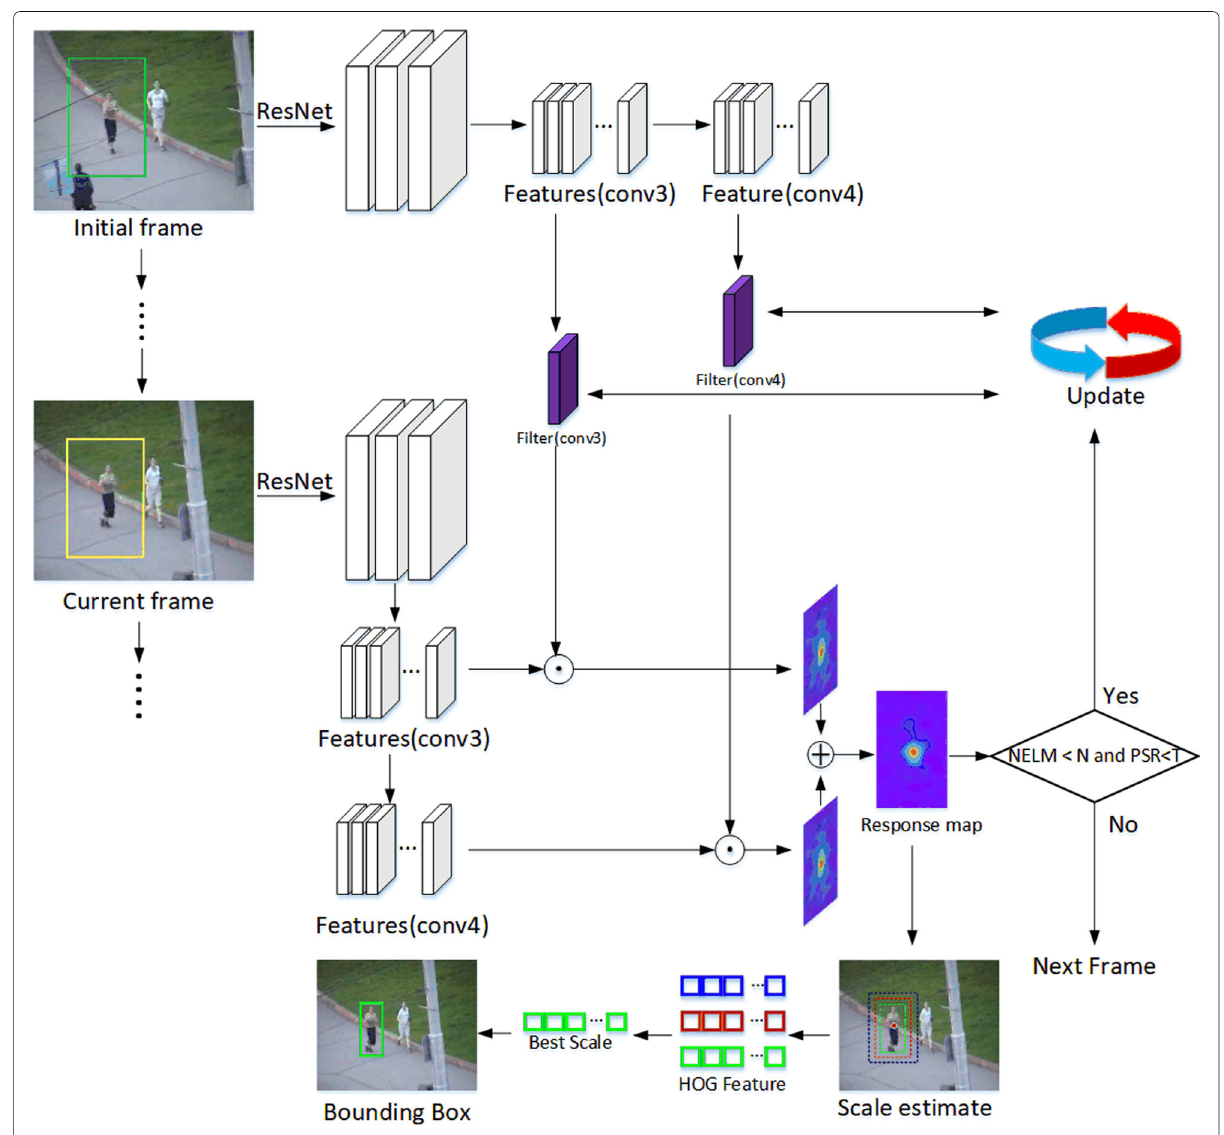
Fig. 1 Procedure of the proposed